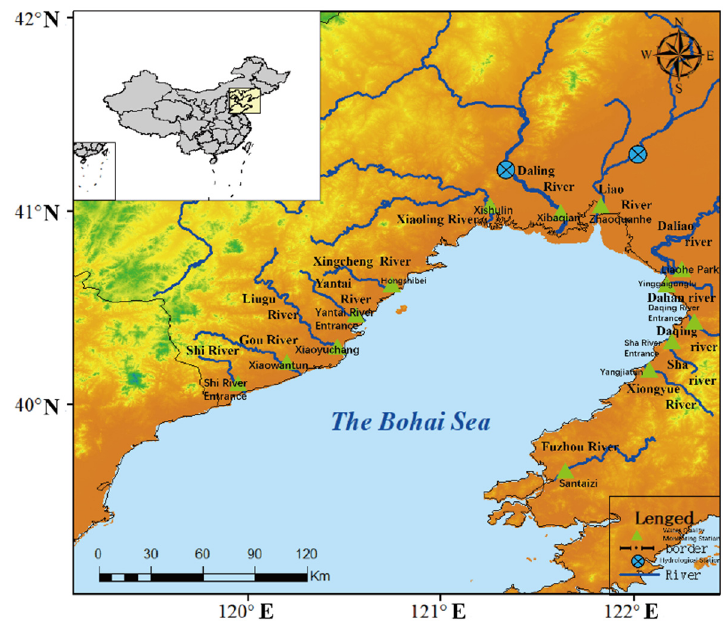
Figure 1. Study area and location.